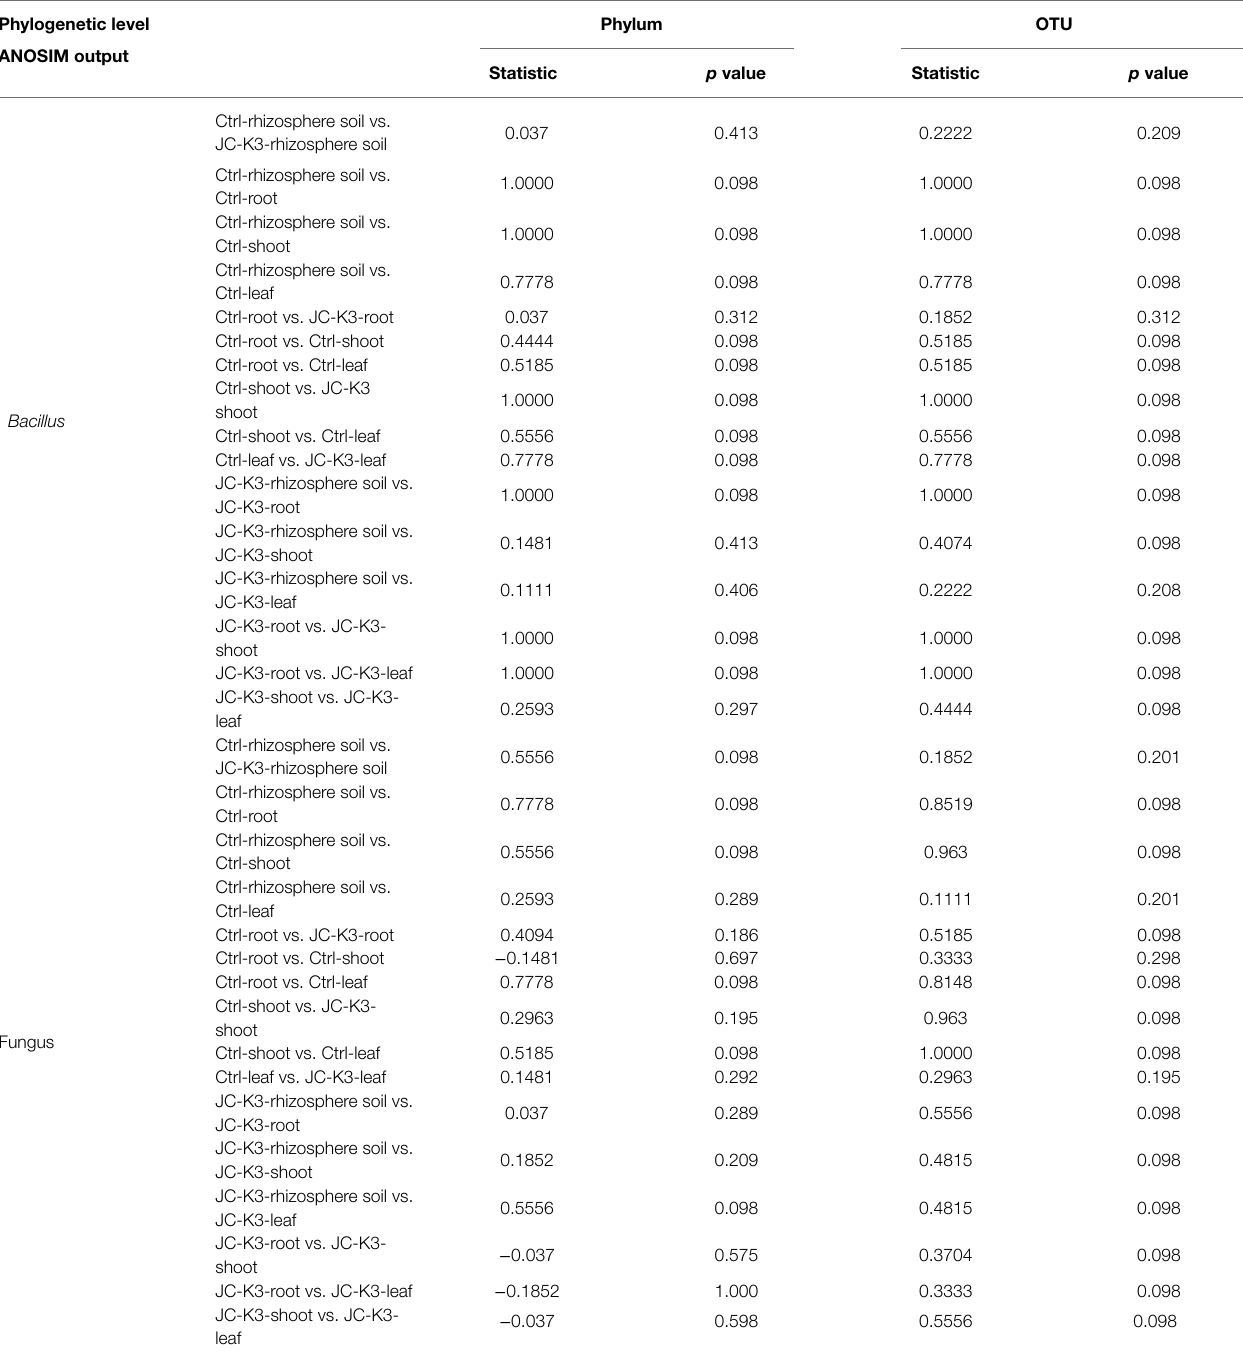
TABLE 3 | Analysis of similarity